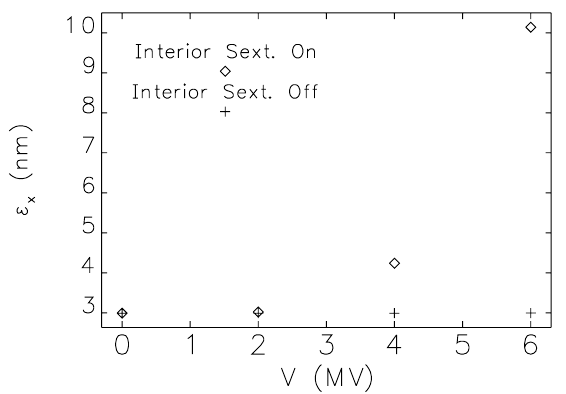
FIG. 11. Eventual horizontal emittance as a function of de- flecting voltage for h (cid:3) 8 , with interior sextupoles on and off, without synchrotron radiation